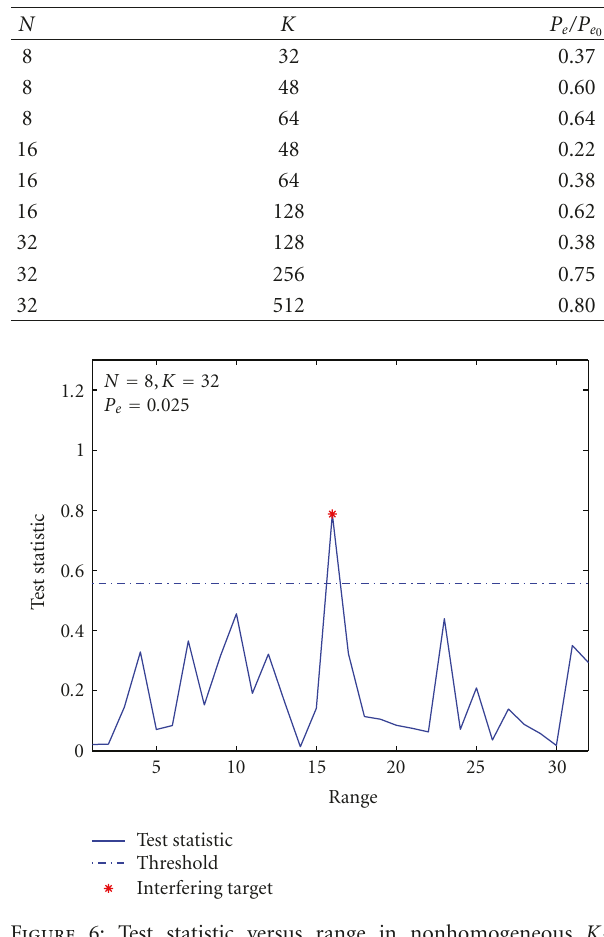
Table 4: The ratio P e /P e homogeneous clutter.